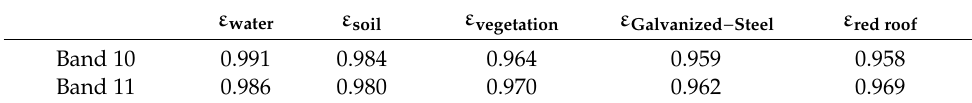
Table 3. The emissivity values of water, vegetation, and soil for Landsat 8 TIRS band 10 and band 11.